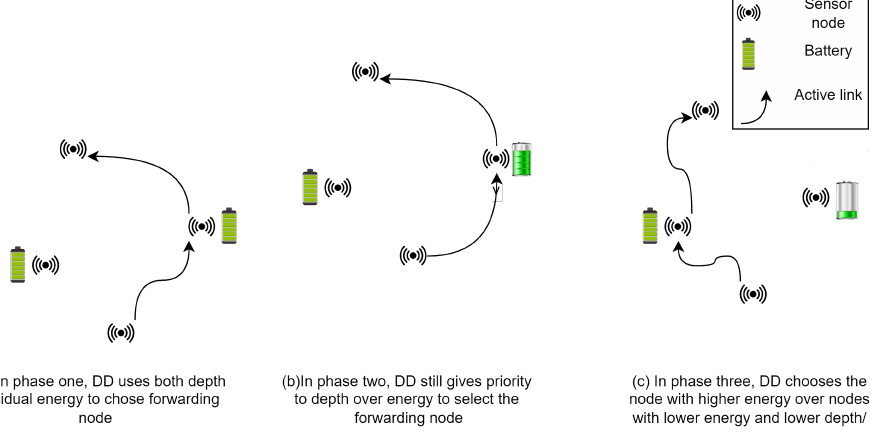
Figure 5. Trend shift in the computation of holding time in RD